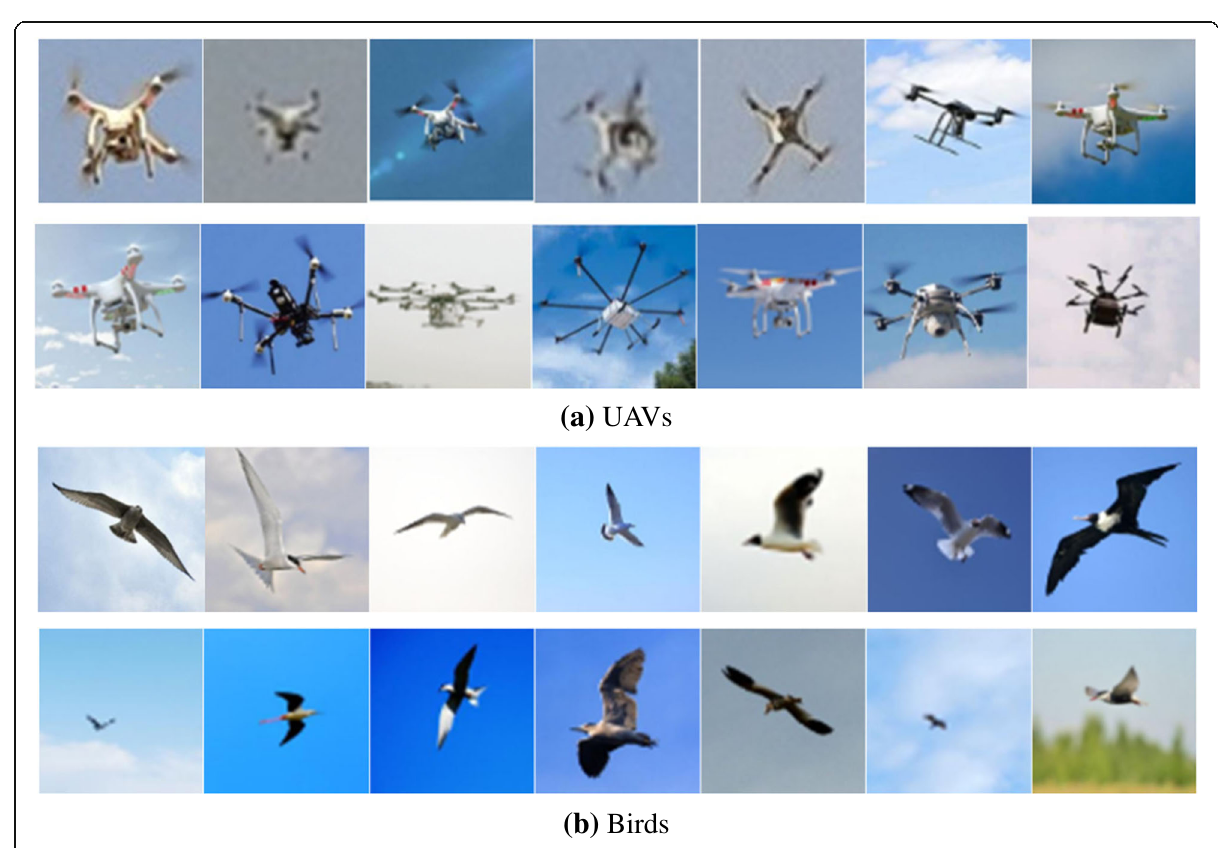
Fig. 3 Part experimental images of two kinds of target object images in the sky. The left side of the figure shows the object images of ( a ) Unmanned Aerial Vehicle (UAV), the right side of the figure shows the target object images of ( b ) Birds target object